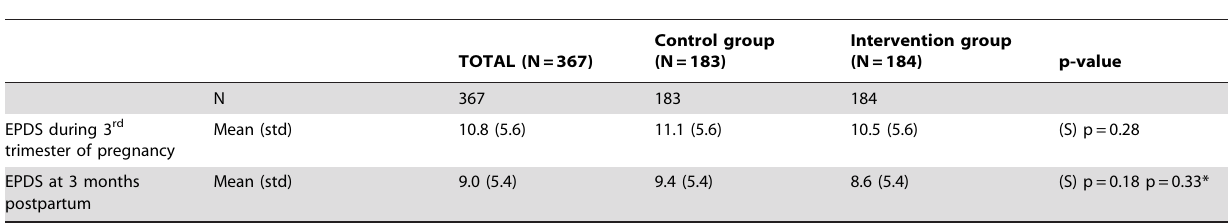
Table 2. Mean (standard deviation) EPDS scores during third trimester of pregnancy (baseline) and 3 months after birth.